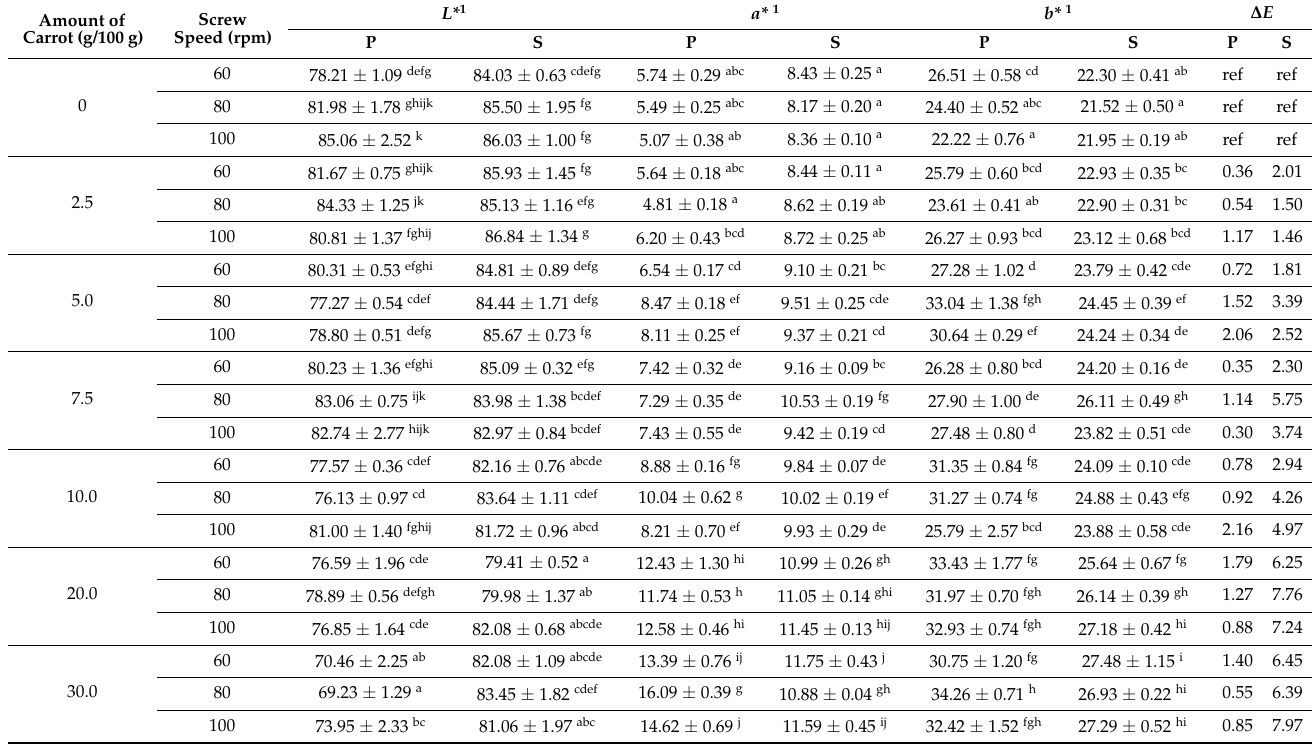
Table 3. The color of pellets and microwave-expanded snacks with the addition of fresh carrot pulp. Amount of Carrot (g/100